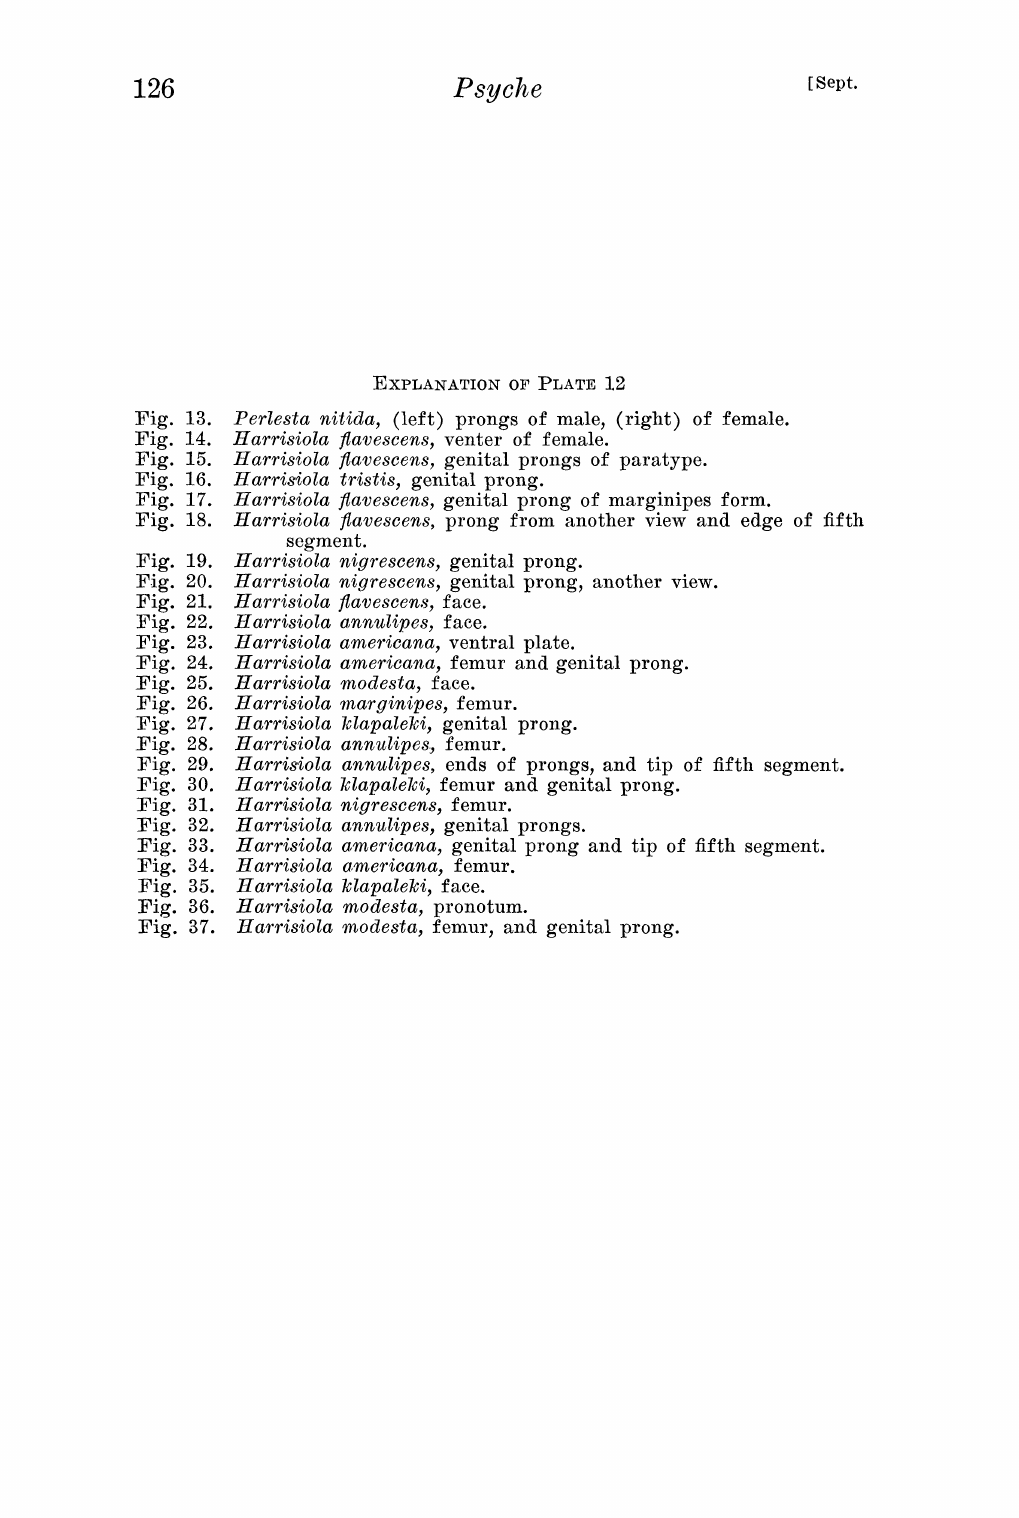
Fig. Fig. Fig. Fig. Fig. F.ig.